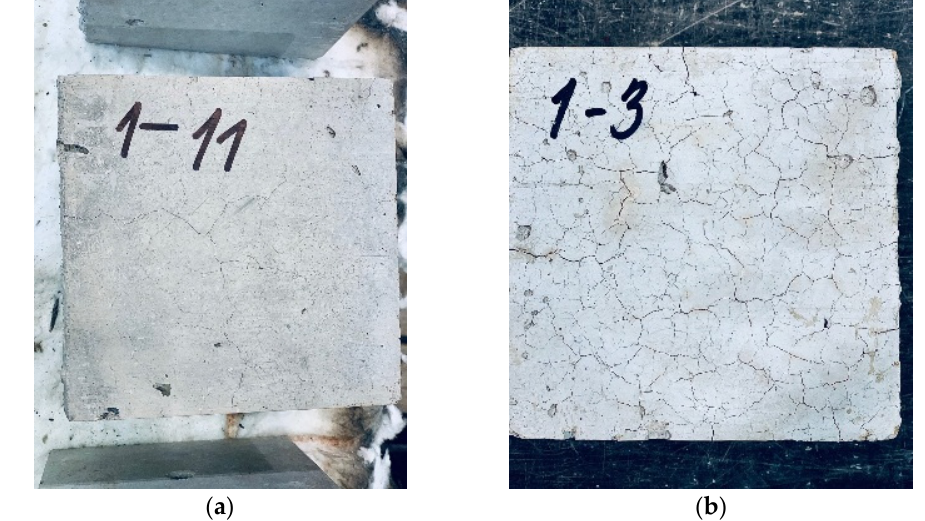
Figure 7. Surface changes in concrete (REC 1). ( a ) Specimen 1–11 loaded to 800 °C–grey surface color and first appearance of cracks. ( b ) Specimen 1–3 loaded to 1000 °C–light grey shade with a slightly pinkish-orange tone and a considerable number of surface cracks.